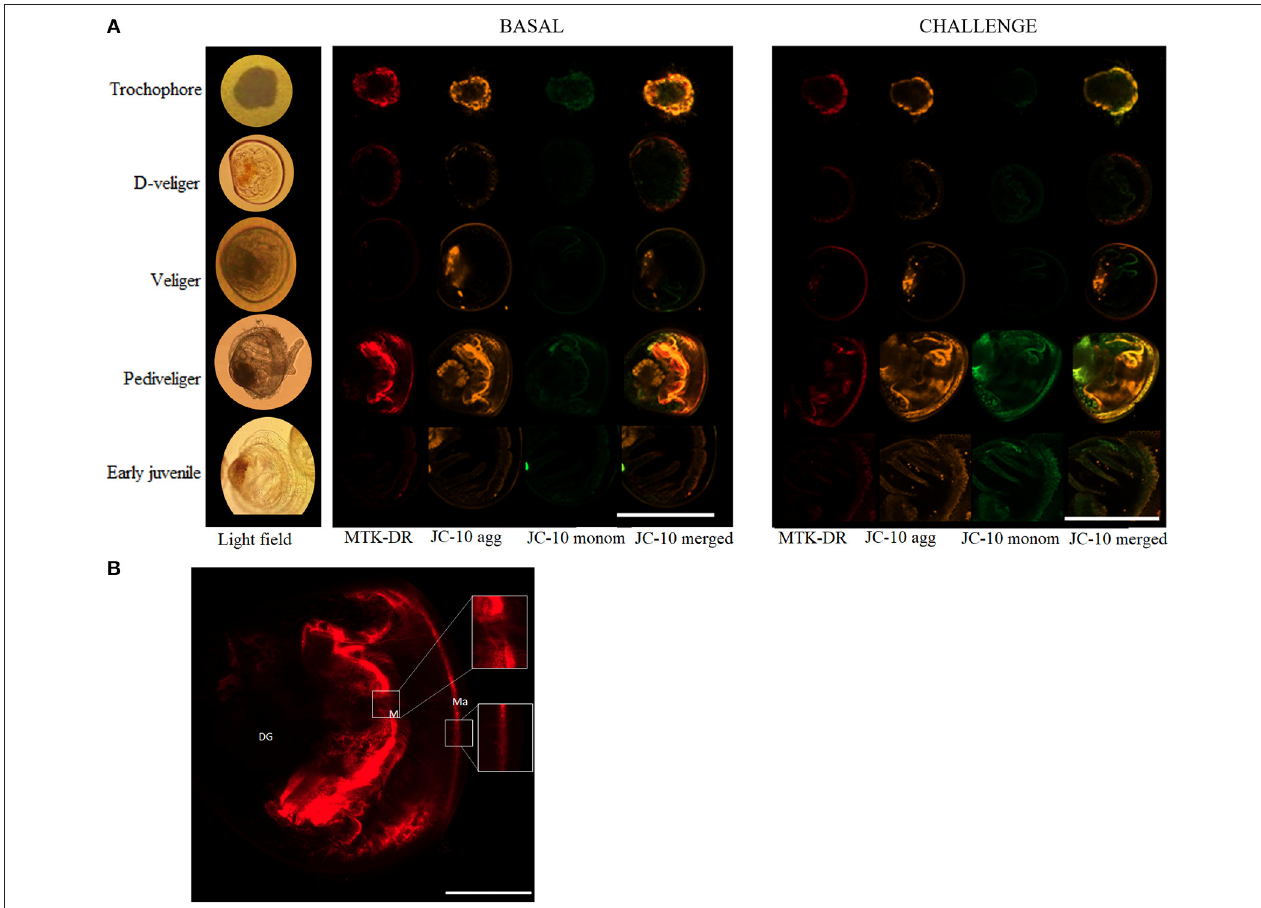
FIGURE 3 | (A) Representative images obtained from in vivo analysis of the mitochondrial relative density ( ρ m) and mitochondrial membrane potential ( 19 m) throughout larval development and in early juveniles of the scallop Argopecten purpuratus in basal (left) and Vibrio challenged (right) conditions. Here ρ m is stained with MTK-DR dye marked in red while 19 m is stained with JC10 dye, monomers are marked in orange and green, the rightmost column is the image resulting from merging JC-10 orange and green channels. Scale bar measure is 160 µ m. (B) Details of the representative image obtained from in vivo analysis of the ρ m in pediveliger undisturbed larvae. Scale bar measure is 40 µ m. Ma, Mantle; M, Mouth; DG, Digestive